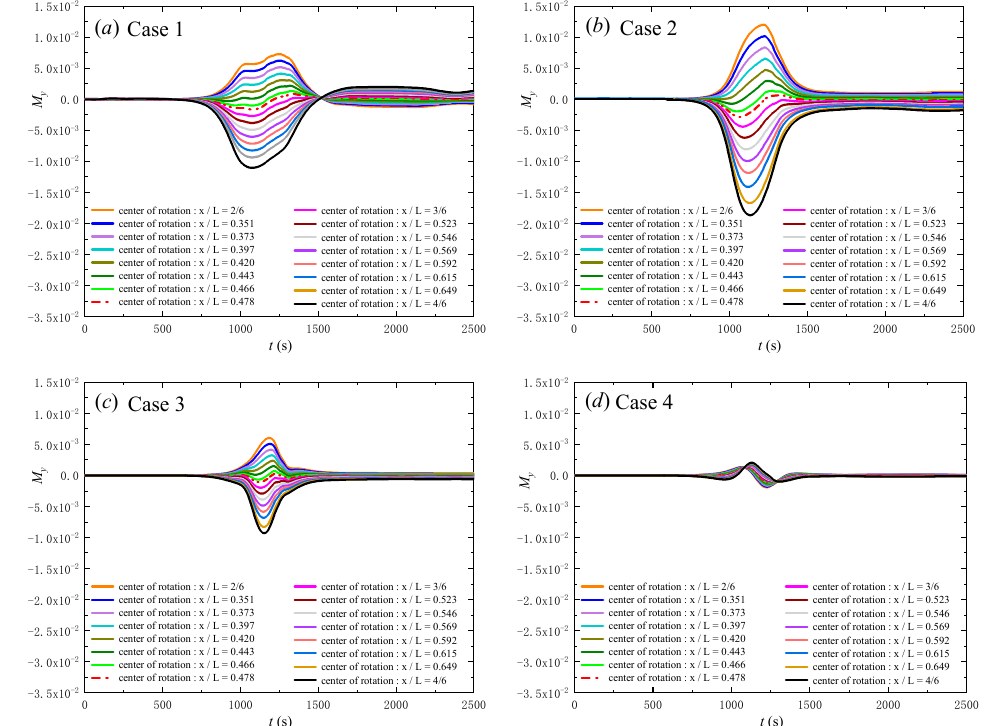
Figure 20. Nondimensional moment of different rotation centre positions for SUBOFF-AFF-8.